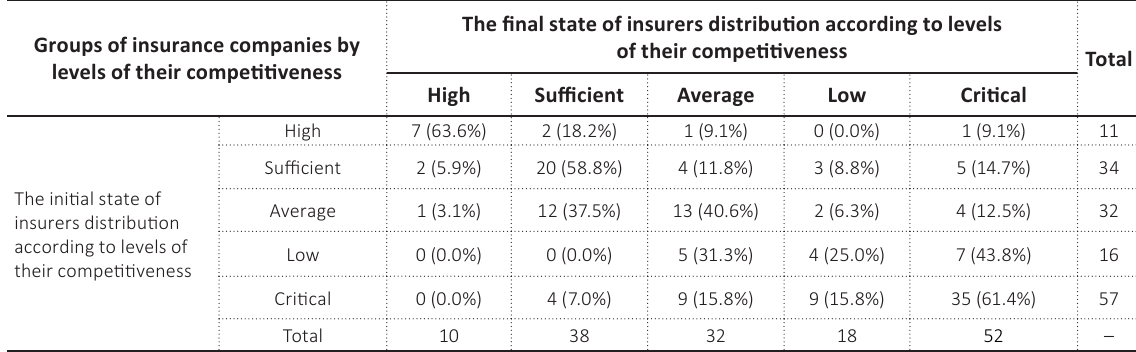
Table 4. Matrix of insurance companies moving between groups according to the levels of their competitiveness on the travel services